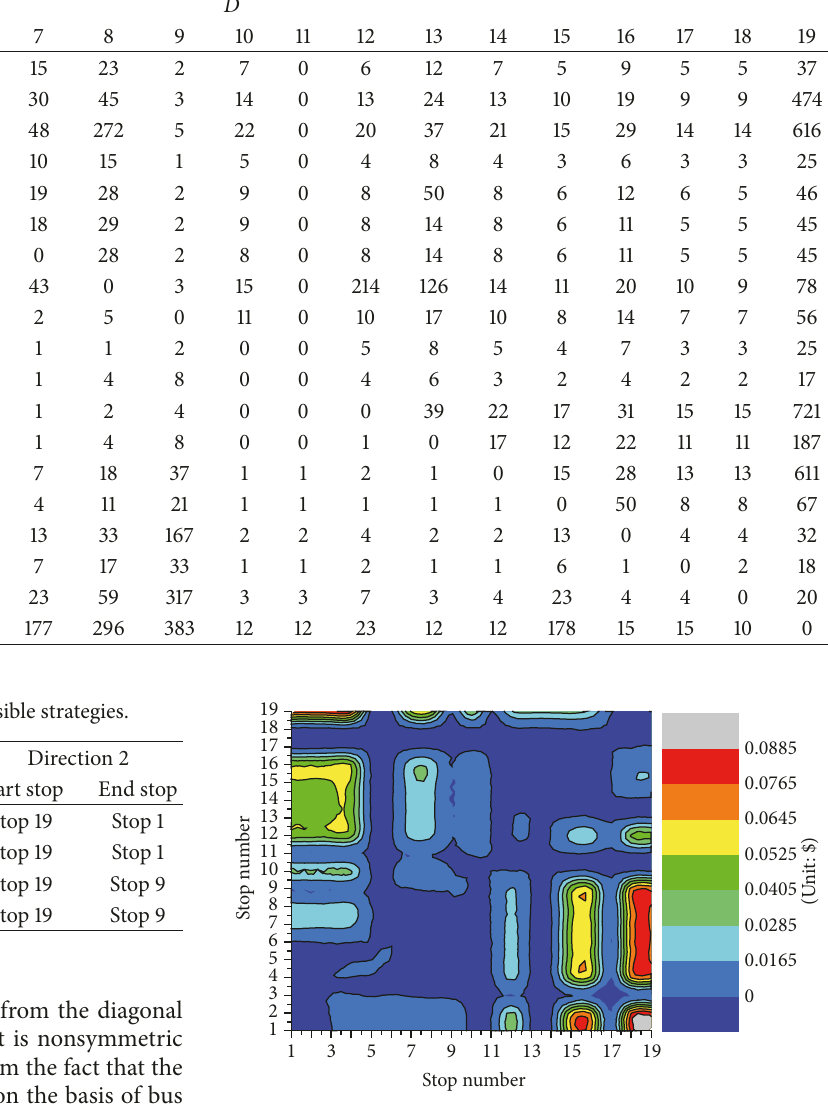
Figure5:Optimalfaresusingstrategiesminusoptimalfareswithout